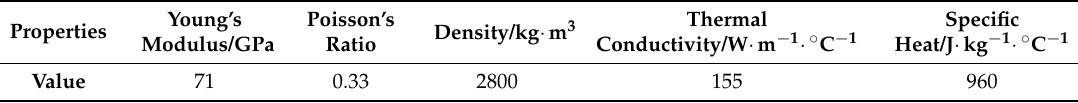
Table 1. Physical parameters of 7075 aluminum alloy.